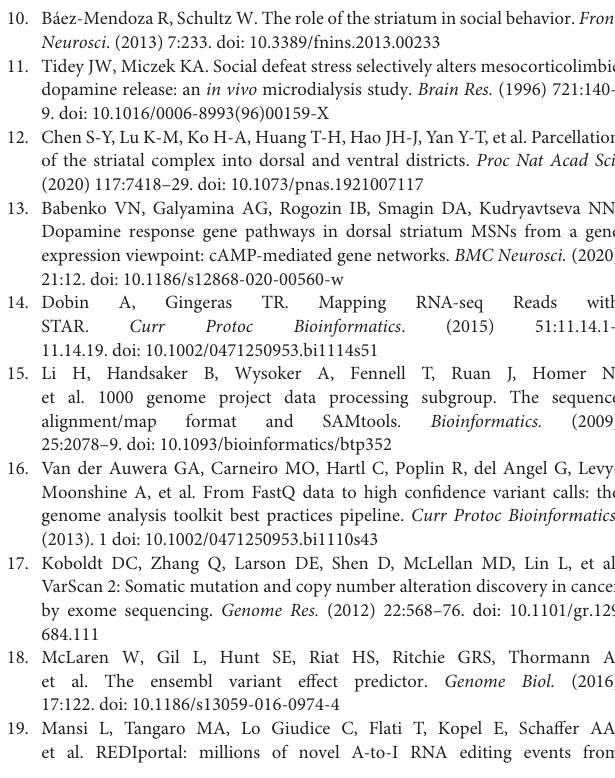
Supplementary Figure 1 | The 10 most divergent A-to-I (G) DRE sites between winners and